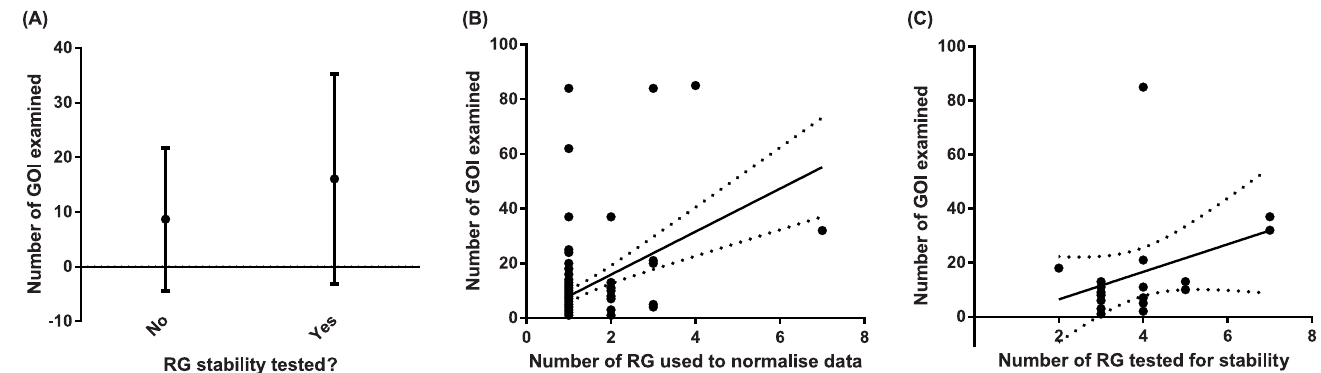
Fig 4. Influence of the number of GOI investigated on the rigor with which RGs are selected and used. (A) Number of GOIs analysed does not affect whether or not the stability of RGs is tested. (B) Number of GOIs analysed does not affect the number of RGs used to normalise data. (C) Amongst those studies that do test a panel of RGs for stability ( n = 19), more RGs are tested in studies subsequently analysing more GOI. For panels (B) and (C), a linear regression (solid line) and 95% confidence intervals (dotted lines) were fitted solely to show the direction of the